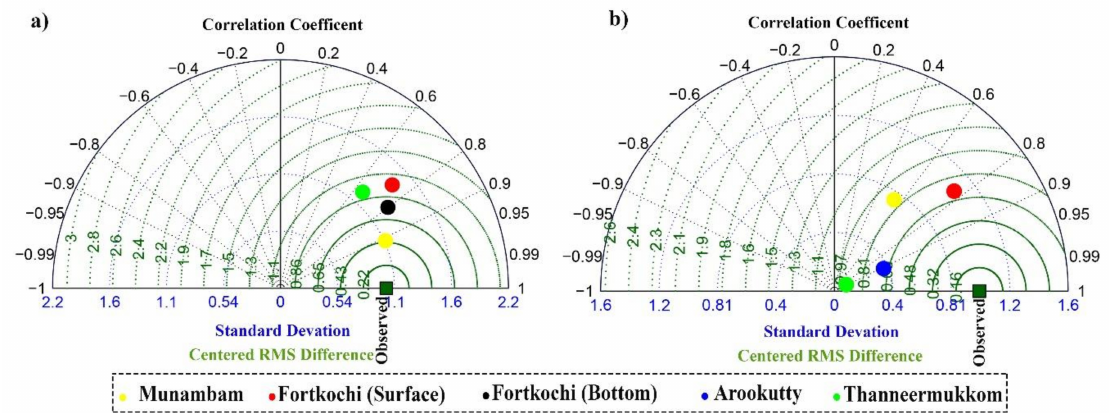
Figure 6. Normalized Taylor diagram for the statistical significance of along-channel velocity of the model during the ( a ) pre-monsoon (2010) and ( b ) monsoon